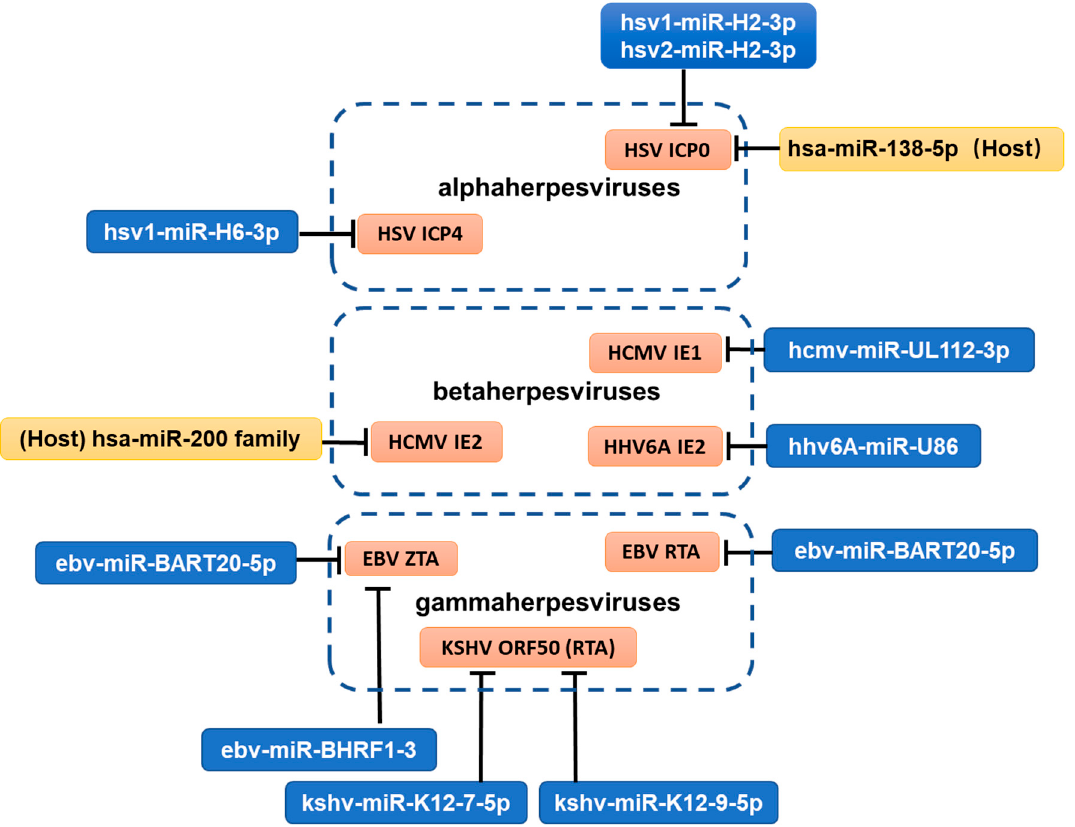
Figure 2. Direct targeting of viral IE genes by viral and cellular miRNAs. Blue rectangles represent viral miRNAs, and yellow rectangles represent host ones.